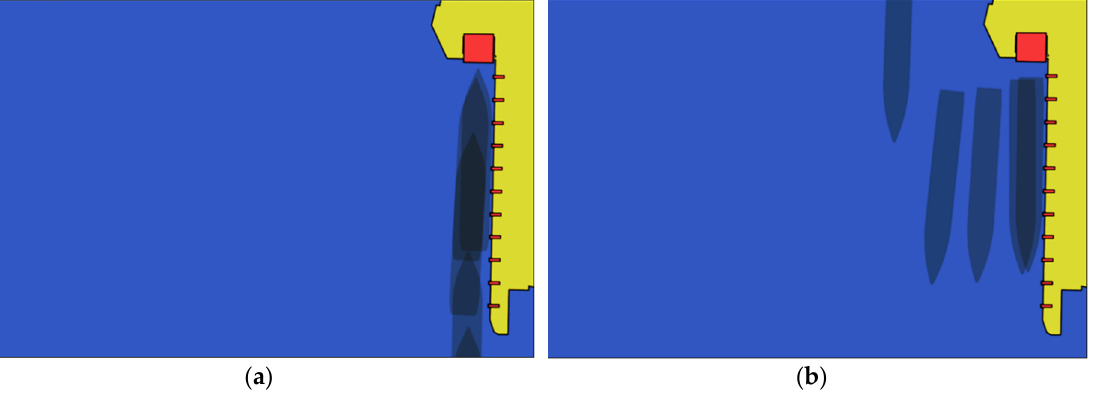
Figure 12. Mazovia ferry longitudinal approach ( a ), Cracovia ferry in transversal approach ( b ).